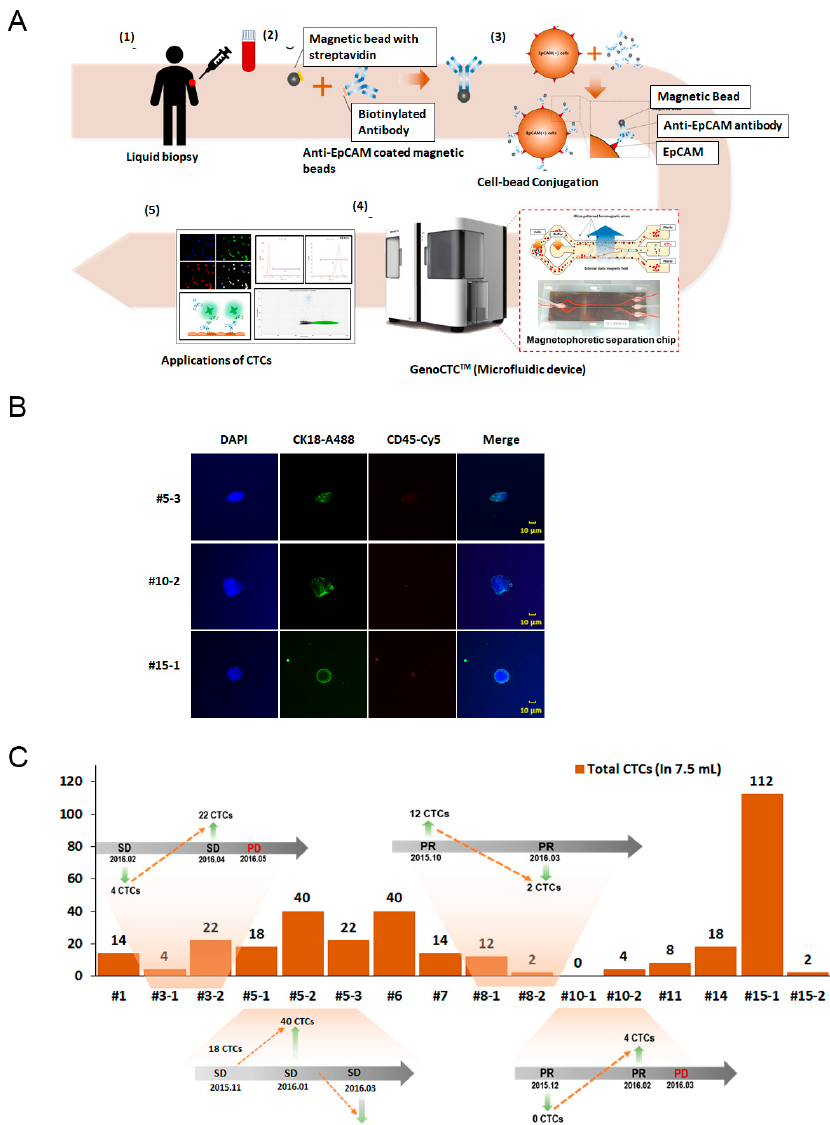
Figure 3. Isolation and enumeration of CTCs from non-small cell lung cancer (NSCLC) patients: ( A ) the detailed GenoCTC workflow using clinical samples is summarized as follows: (1) Whole blood is drawn from cancer patients. (2) The biotinylated anti-EPCAM antibody is conjugated with 1 μ m streptavidin-coated magnetic nanobeads. (3) Anti-EPCAM antibody-coated beads and whole blood are incubated together, and the nanobeads will specifically bind onto EPCAM-positive cells. (4) EPCAM-positive cells are isolated using GenoCTC with a disposable GenoChip. (5) Molecular analysis is conducted in various ways using isolated EPCAM-positive cells. ( B ) Representative fluorescent images of isolated EPCAM-positive cells from three NSCLC patients are shown. Cells were immunostained with DAPI for nuclear staining (blue), an anti-cytokeratin 18 (CK18) antibody for CTCs (Alexa flour488; Green), andan anti-CD45 antibodyfor leukocytes (Alexa594; red). ( C ) EPCAM-positive cells isolated from the whole blood of 10 NSCLC patients were enumerated, and the number of cells observed varied between patients. EPCAM-positive cell counts ranged from 2 to 112 in 3.5 mL of whole blood, and the average count of the cells was 20.75, showing 95% confidence. The orange shaded area show the serial assessment of CTCs from those patients. The grey arrows indicate the clinical changes in the disease status determined by a physician. SD: stable disease, PR: partial response, PD: progressive disease. The orange arrows indicate the increase or decrease in CTC counts during the serial